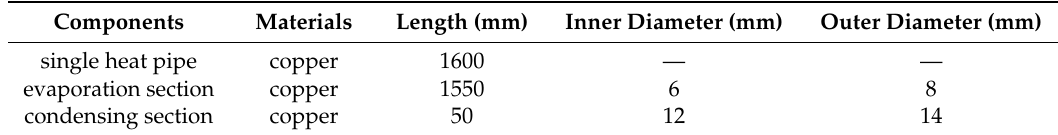
Table 1. The design parameters of a solar gravity heat pipe used in